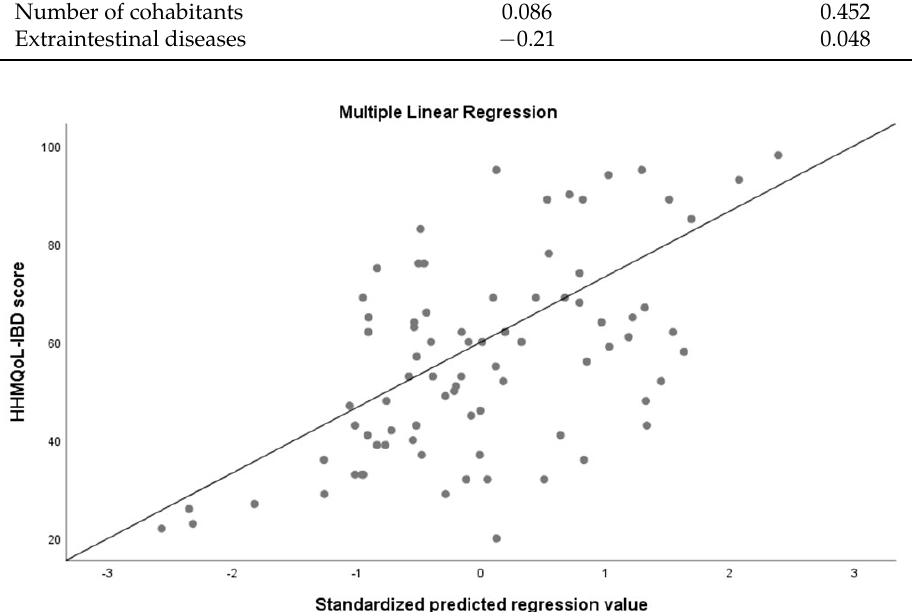
Figure 4. Multiple linear